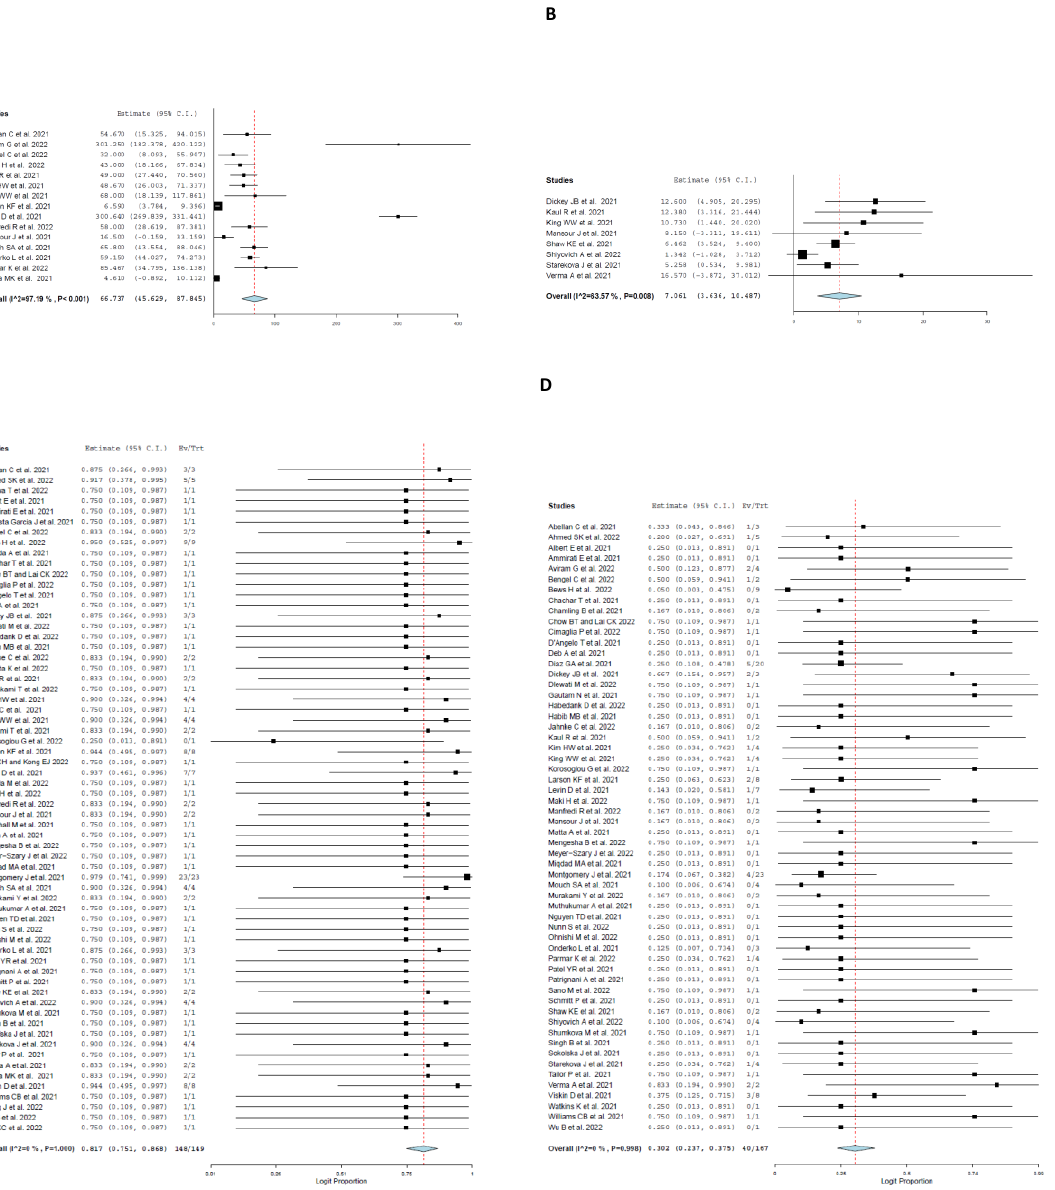
Figure 3. Forest plot of laboratory findings at time of admission. ( A ) C Reactive Protein. ( B ) Cardiac Troponin-I. ( C ) Elevated Troponin. ( D ) Left Ventricular Ejection Fraction Less Than 50%.